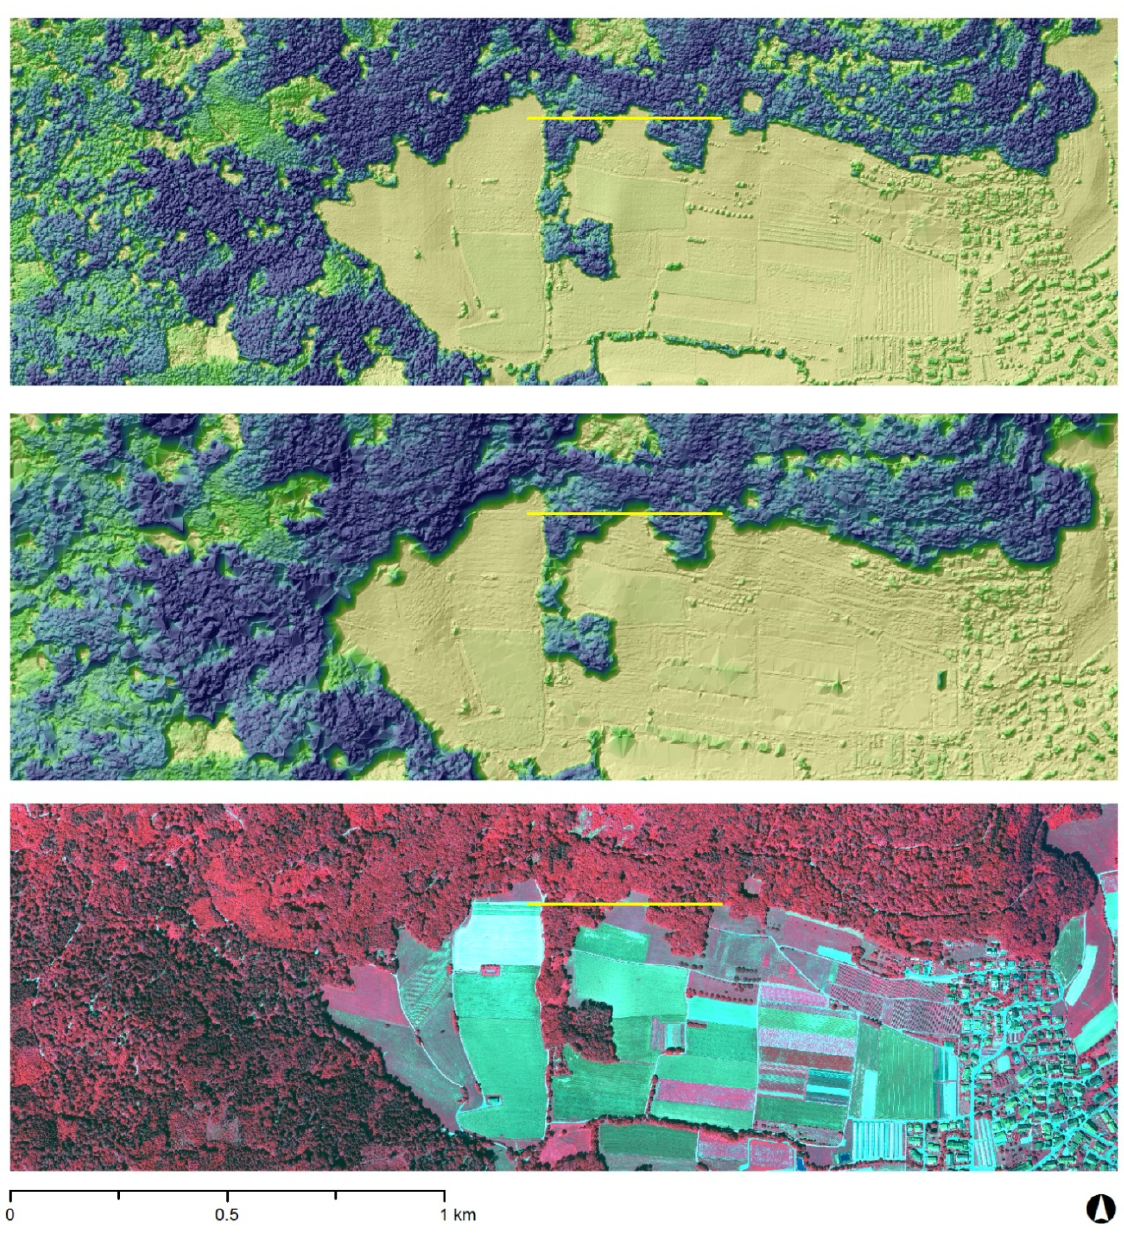
Figure 4. Hillshades of the ADS80 DSM (top) and the WorldView-2 GCP-enhanced RPCs DSM (centre) as well as the ADS80 CIR image of the chosen extent (bottom). Profile of Figure 5 in